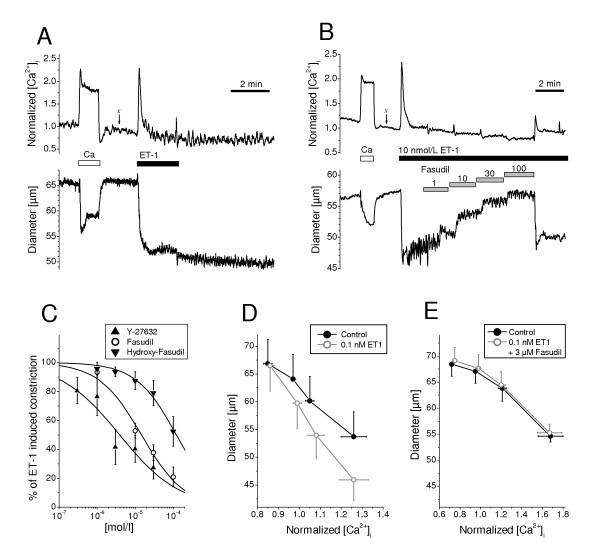
Rho-kinase inhibitors reverse ET-1-induced constriction. A) Effect of 10 nmol/L endothelin-1 (ET-1) on the cytosolic Ca2+ concentration ([Ca2+]i) and the vascular diameter of the spiral modiolar artery. Note that ET-1 caused a transient increase in [Ca2+]i and a sustained vasoconstriction and increase in vasomotion. This constriction outlasted the stimulation with ET-1. Increasing extracellular Ca2+ concentration ([Ca2+]ex) to 10 mmol/L ("Ca") induced an increase in [Ca2+]i with parallel vasoconstriction. This increase of the [Ca2+]ex from 1 to 10 mmol/L ("Ca") served as a control experiment. Measurements of [Ca2+]i were normalized to the value obtained prior to the admission of ET-1 (value at time 'x' was set to 1). B) In the presence of 10 nmol/L ET-1, increasing concentrations of fasudil (1–100 μmol/L) induce dose-dependent relaxation. [Ca2+]i values were normalized, with the baseline value prior to application of ET-1 designated as 1.0 (denoted as "x"). C) Dose-response curves for Y-27632-, fasudil- and hydroxy-fasudil-induced reversal of ET-1 (10 nmol/L) -mediated vasoconstriction. C) ET-1 stimulated a significant increase in VSMC contractile apparatus Ca2+ sensitivity. D) Fasudil completely reversed the ET-1-induced Ca2+-sensitization.